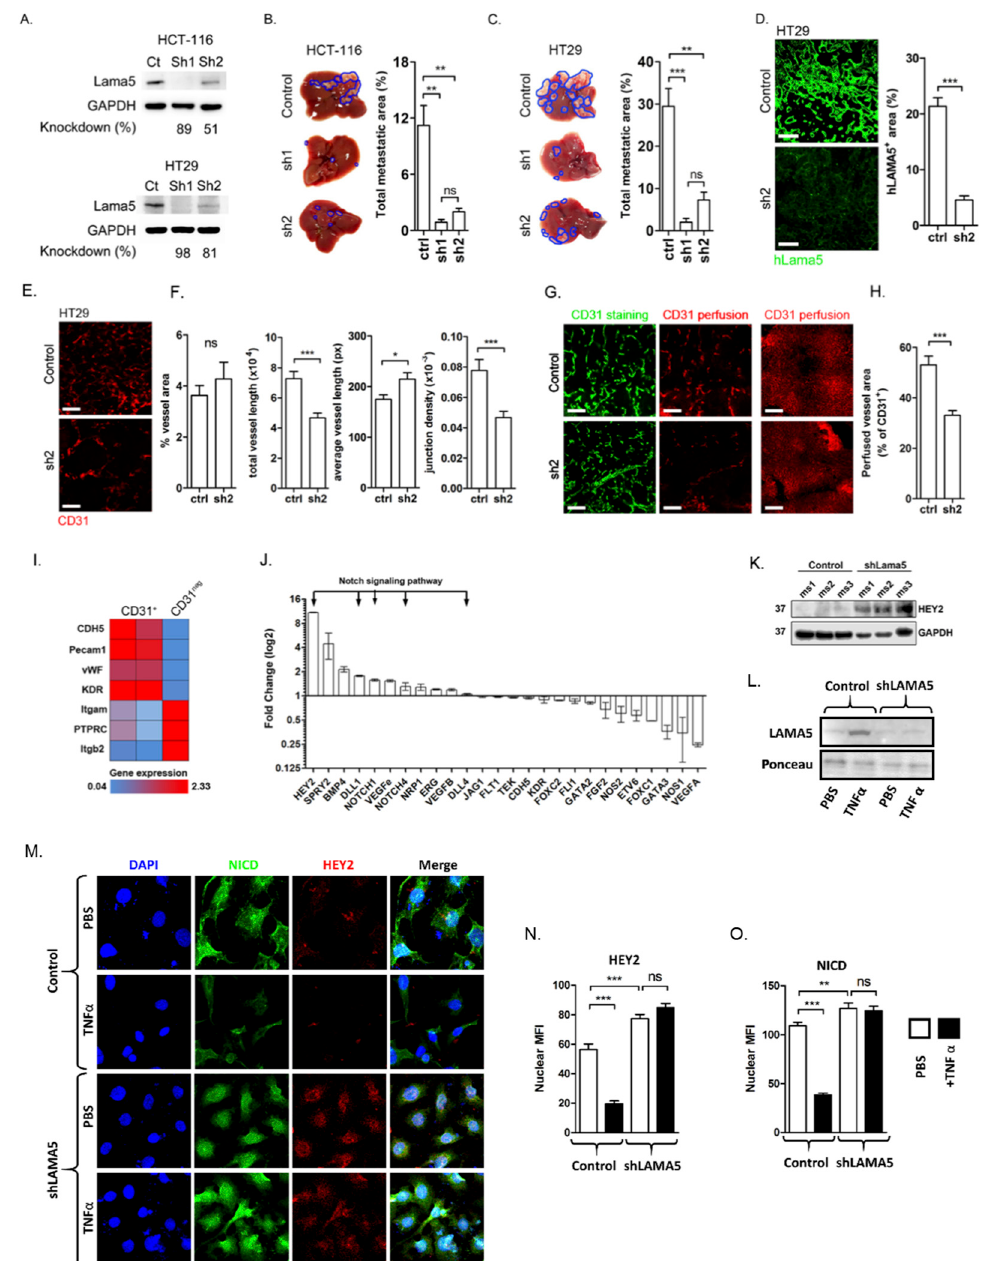
Figure 4. Inhibition of tumour-derived LAMA5 inhibits the growth of colorectal liver metastases and promotes endothelial Notch signalling. ( A ) Western blotting for LAMA5 in Hct-116 and HT29 colon cancer cell lines transfected with non-targeting control (ctrl) or one of two LAMA5 shRNA constructs (sh1 or sh2). ( B ) Liver metastasis growth in Hct-116 ctrl and Hct-116-sh1 or Hct-116-sh2 cell lines. ( C ) Liver metastasis growth in HT29ctrl and HT29-sh1 or HT29-sh2 cell lines. ( D ) Immunofluorescence staining for the human LAMA5 protein in liver metastases developed using HT29ctrl or HT29-sh2 cell lines. Scale bars represent 40 µ m. ( E ) Immunofluorescence staining for CD31 in liver metastases developed using HT29ctrl or HT29-sh2 cell lines. Scale bar represents 40 µ m. ( F ) Quantification of total CD31 + area, total and average vessel length and vessel junction density in liver metastases developed using HT29ctrl or HT29-sh2 cell lines. ( G ) Immunofluorescence staining for vessel perfusion (tail vein injection of anti-CD31) in red and endothelial cells (immunohistochemistry for CD31) in green in HT29ctrl and HT29-sh2 liver metastases. Scale bars represent 40 µ m. ( H ) Quantification of the percentage of perfused vessels in liver metastases developed using HT29ctrl and HT29-sh2 cell